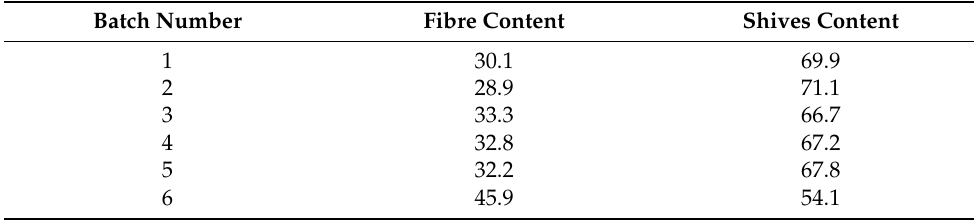
Table 3. Contents in fibres and shives in the different straw batches tested (determination through manual extraction) (% in